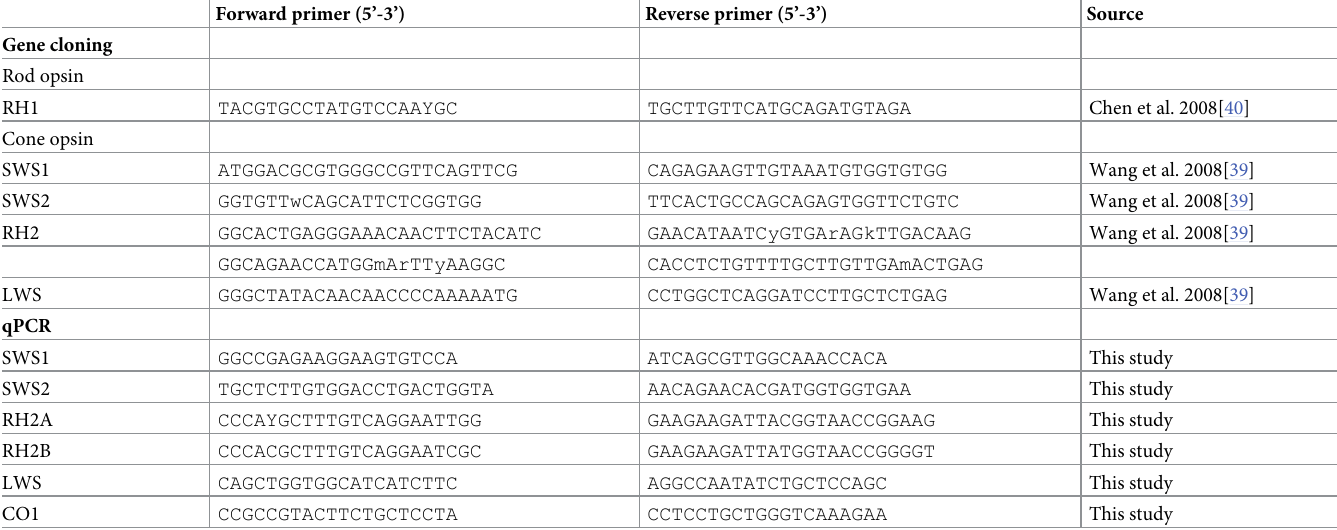
Table 2. Primer sequences used in red shiner opsin gene cloning and qPCR reactions. Forward primer